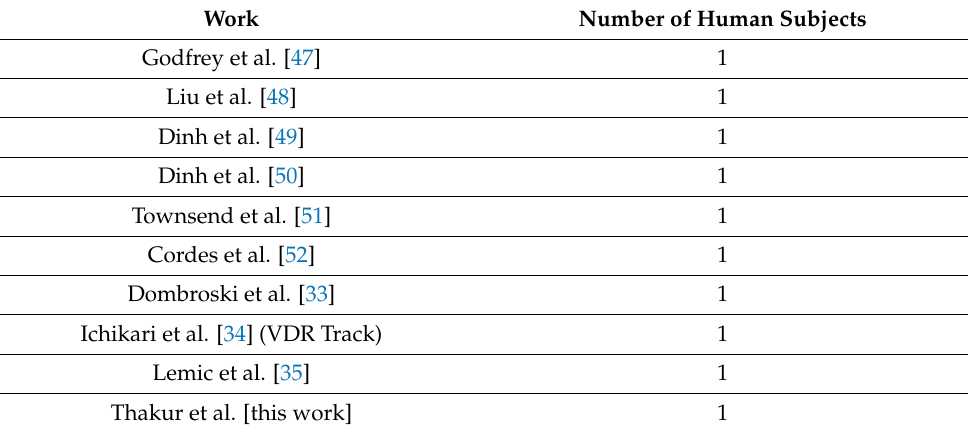
Table 2. Prior works in the field of fall detection, indoor location, and assisted living tested using the data from only one human